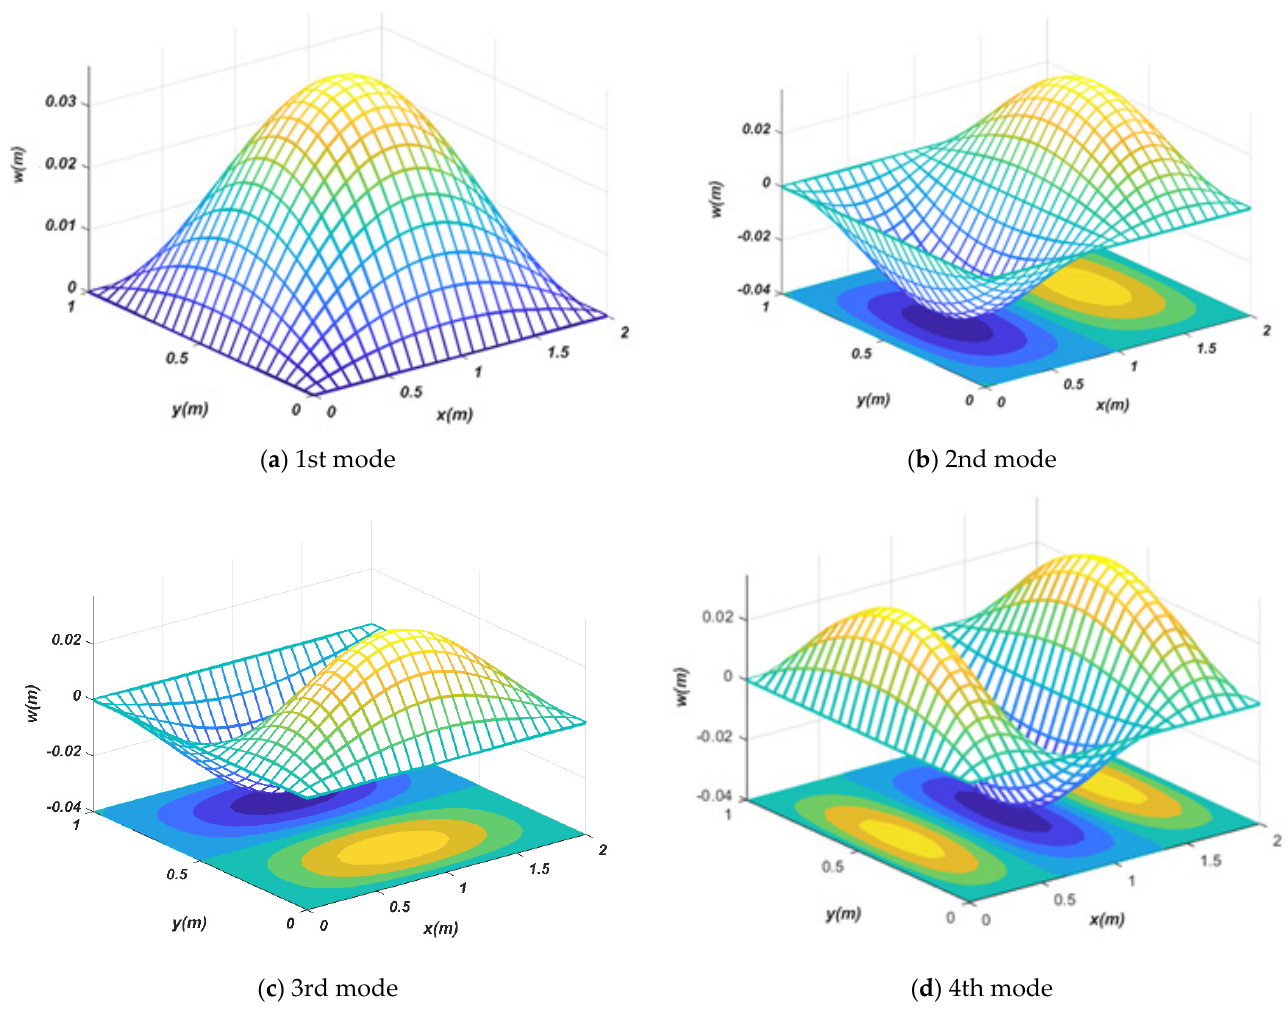
Figure 8. First four buckling mode shapes of a FG-saturated porous plate subjected to a biaxial load (SSSS, a = 2 m, b = 1 m).